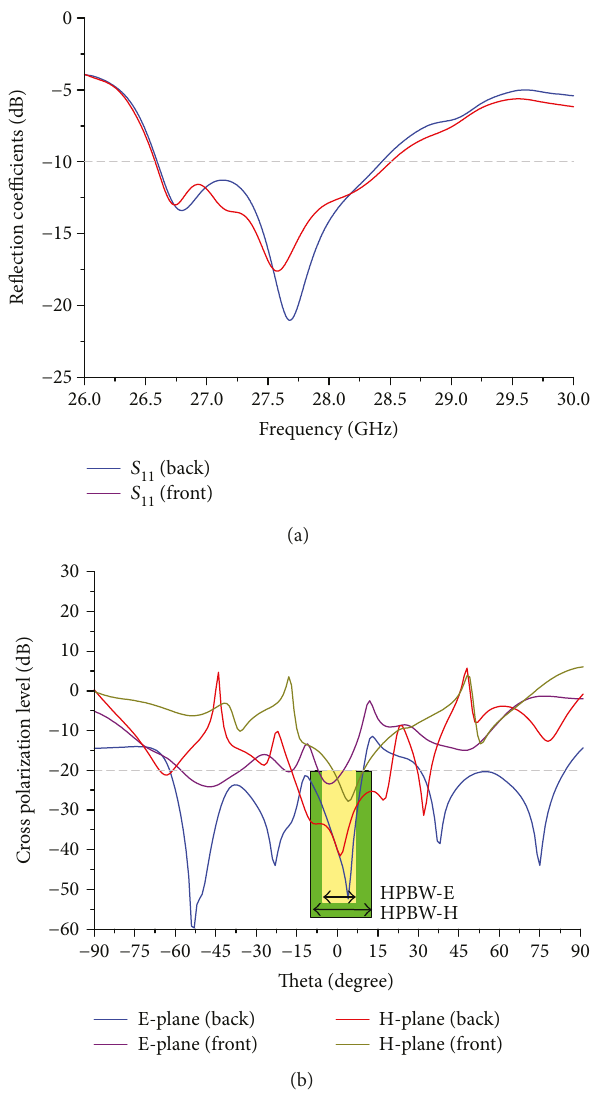
Figure 5: (a) The re fl ection coe ffi cients and (b) cross polarization levels for di ff erent transition positions.